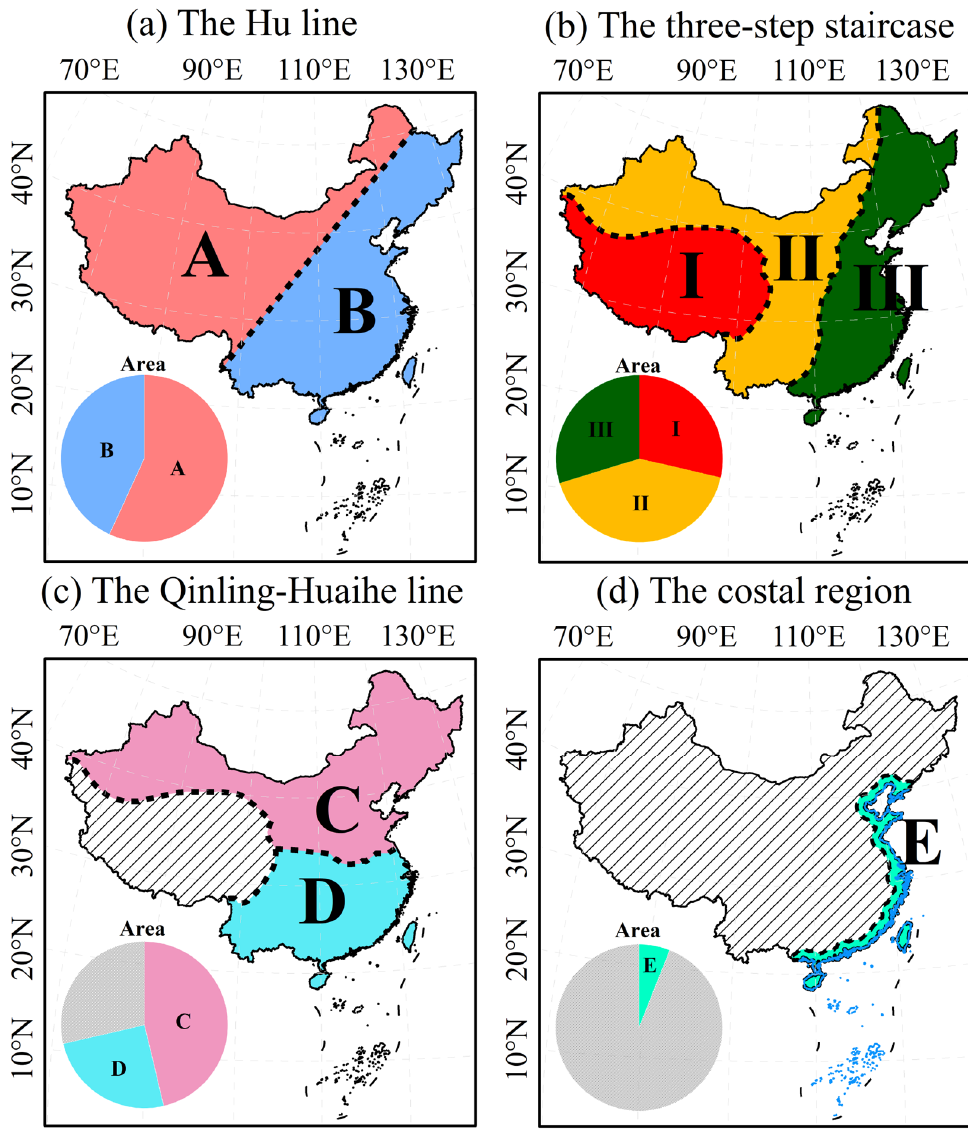
Figure 5. Regional divisions. Regions A and B in panel ( a ) represent the areas northwest and southeast of the Hu line; regions I, II, and III in panel ( b ) represent the first, second, and third steps of China’s natural terrain; regions C and D in panel ( c ) represent the division of the North and South of China; and region E in panel ( d ) is the coastal region within 100 km of China’s coastline. The pie graph in the lower left corner of each panel represents the share of each region in the national total.